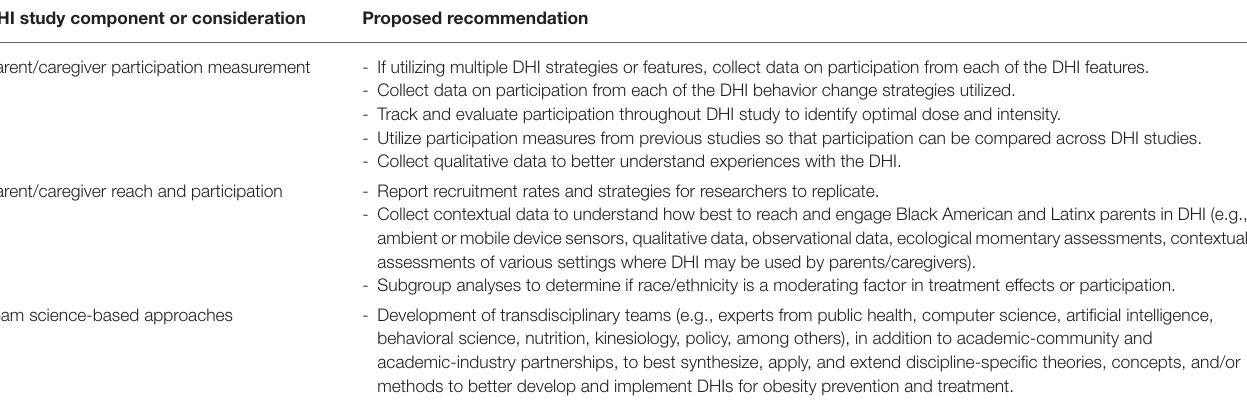
TABLE 3 | Recommendations for future DHI